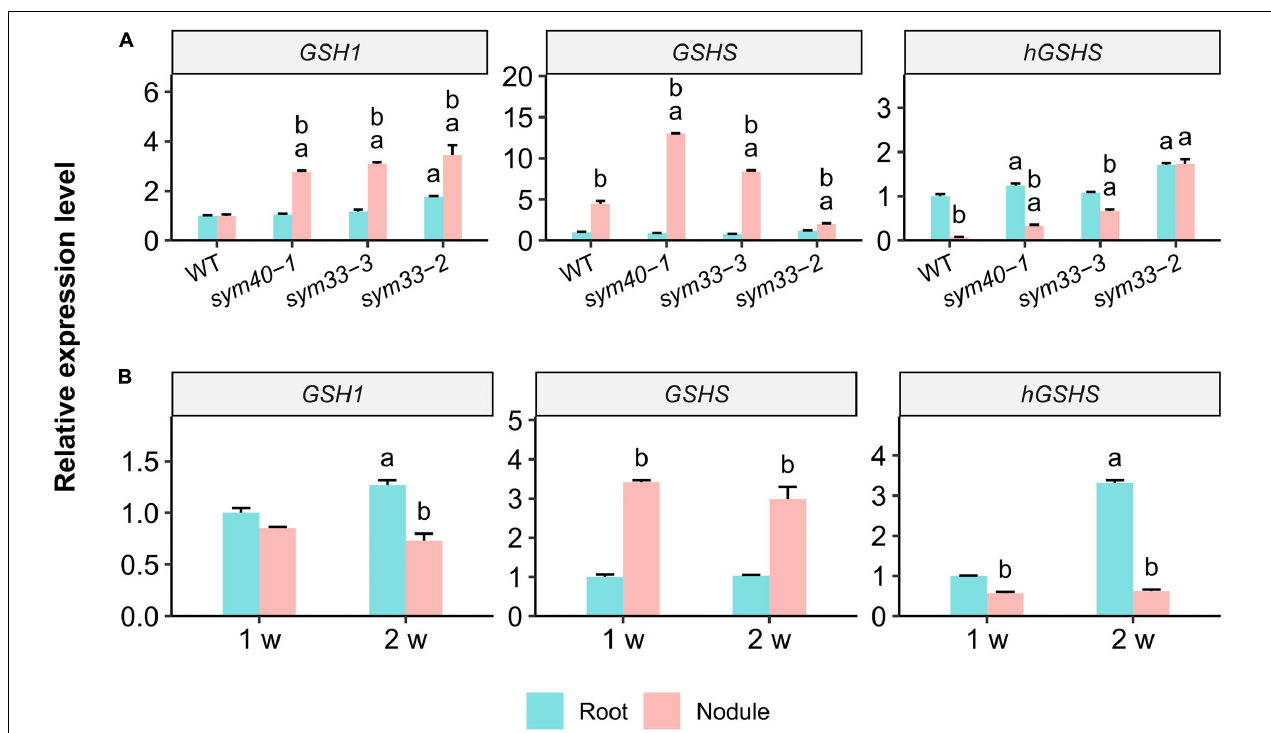
FIGURE 5 | The relative expression levels of glutathione biosynthesis-related genes in nodules and roots of wild-type (WT) and mutant ( sym40-1 , sym33-3 , and sym33-2 ) pea ( Pisum sativum ) plants. (A) Three-week-old uninoculated roots and nodules. (B) One- and two-week-old uninoculated roots and nodules of wild type. Transcript levels were determined by real-time PCR. Relative gene expression levels were quantified using the 2 − (cid:49)(cid:49) Ct method and normalized to those of the reference gene glyceraldehyde-3-phosphate dehydrogenase ( PsGAPC1 ). Three-week-old (A) and 1-week-old (B) wild-type uninoculated (control) roots were used as calibrators for the calculation of relative transcript abundance. The graphs show the results of three independent experiments. Lowercase letters indicate significant differences (two-way ANOVA, P < 0.05) between the expression of each gene for different groups as follows: (A) a, effect of the genotype (each genotype was compared to the wild type separately for roots and nodules); b, effect of the inoculation (nodules were compared with roots for each genotype); (B) a, effect of the age of the wild-type roots; b, effect of the inoculation for each time